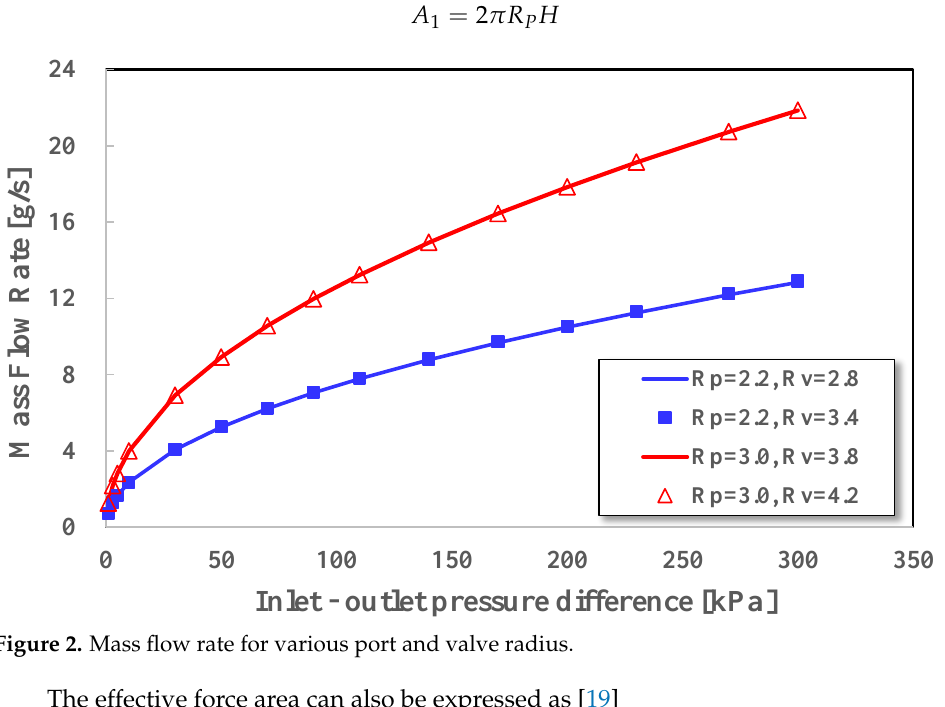
Figure 2. Mass flow rate for various port and valve radius.